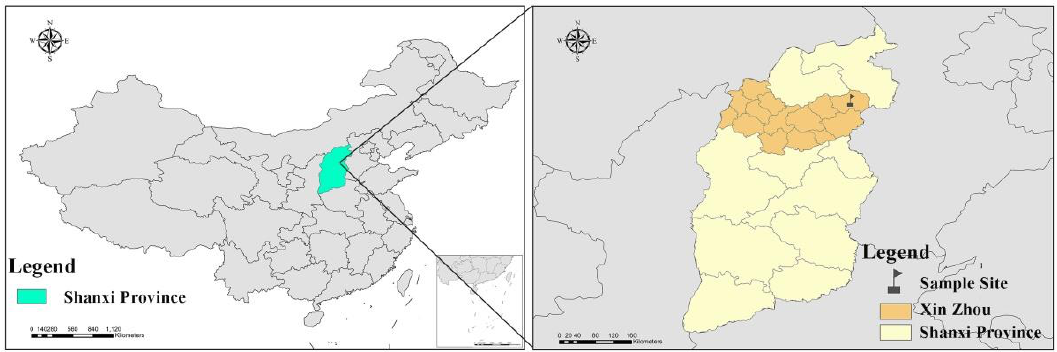
Figure 1. Sampling location of polycyclic aromatic hydrocarbons in Xinzhou city, Shanxi Province.